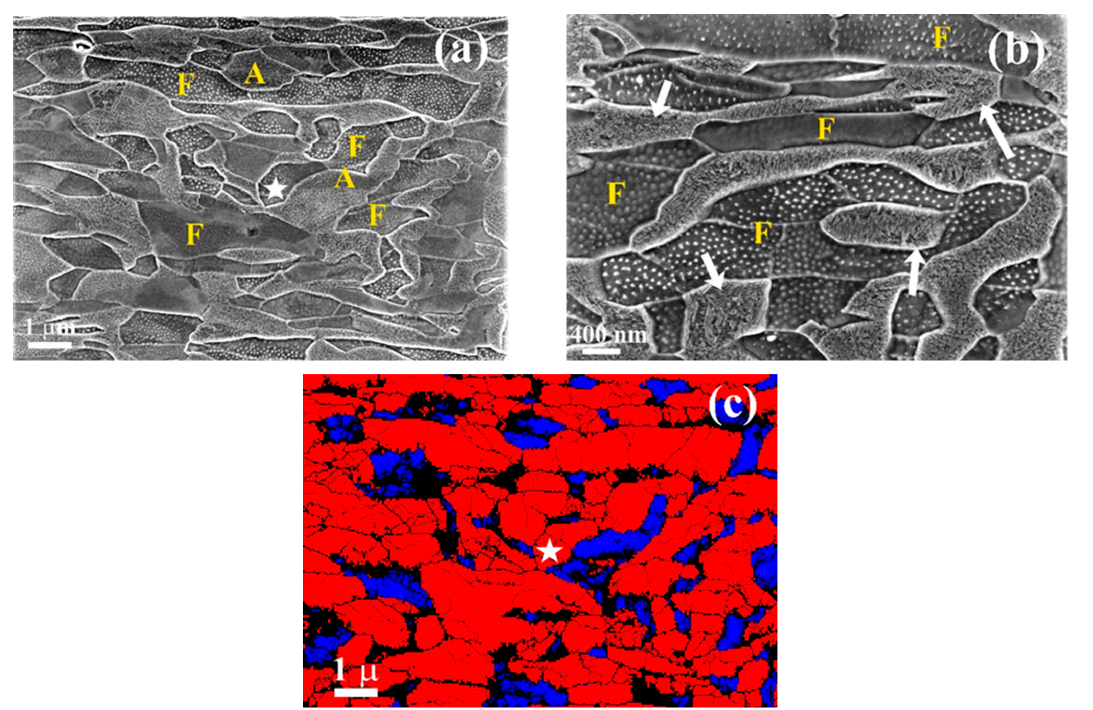
Figure 4. ( a ) SEM micrograph showing the microstructure of a specimen tested at 75 °C to fracture. Both DIM and retained austenite were found. ( b ) SEM micrograph showing some incomplete trans- formed austenite grains, as marked by arrows. ( c ) EBSD phase map of ( a ) showing some areas of retained austenite after tensile test. F: ferrite, A: austenite. Blue color represents fcc phase, red color represents bcc phase, and black color represents unindexed points. White stars are registration marks. Increasing the tensile test temperatures to 100 °C and 125 °C, the microstructures re- vealed in Figure 5 changed considerably. Nearly all austenite grains showed a very fine deformation-induced structure, which appeared as a concave structure in the austenite grains. The arrows in Figure 5b mark the areas of untransformed austenite, which exhib- ited a relatively smooth surface. Figure 5c shows a higher magnification of the area high- lighted by the dotted line in Figure 5b, and the white arrow in Figure 5c indicates the untransformed austenite area. We note that in Figure 3a,b, DIMs appeared on top of the austenite grain surfaces, and they had a convex rather than a concave appearance. Figure 5d is the EBSD phase map of Figure 5b. The deformation-induced fine structure has been indexed by the EBSD either as the bcc phase or as being unable to be resolved due to its very fine structure and the strain field in it. The austenite fractions after tensile test at 100 °C and 125 °C dropped to very low values of 5% and 4%, respectively.